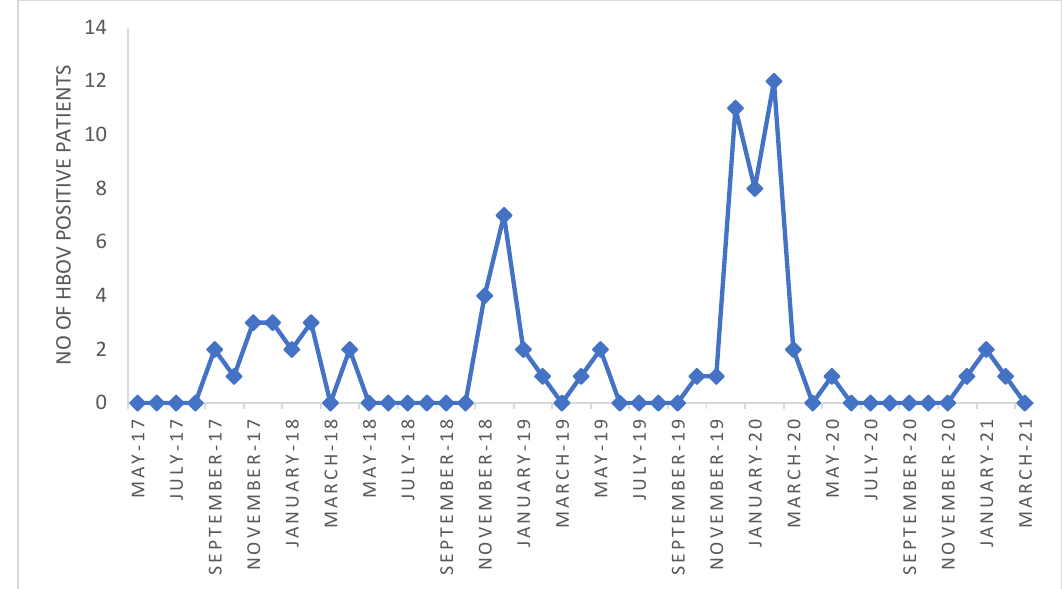
Figure 1. Temporal distribution of the human bocavirus (HBoV) detected ( n = 73) between May 2017 and March 2021.